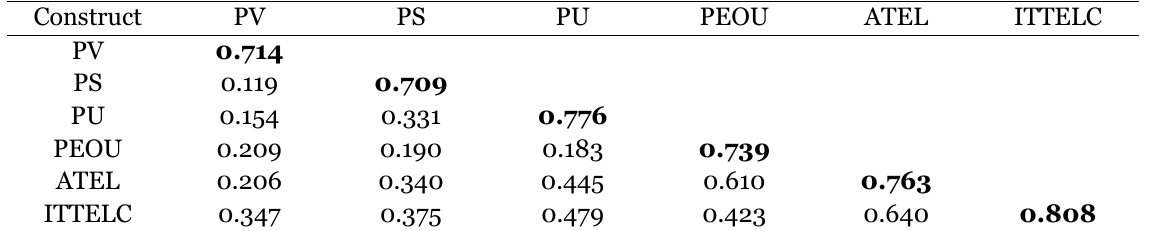
Results of Discriminant Validity Analysis for Measurement Model